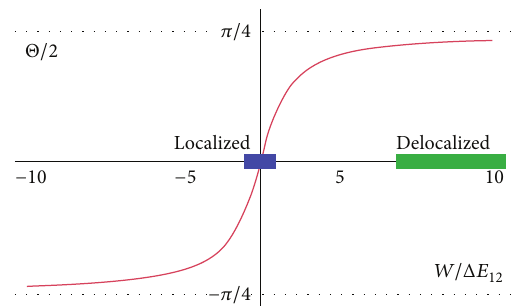
Figure 2: Relation between the parameter Θ and the QW coupling coefficient in a DQW. The ranges for localized and delocalized states of the electron in DQW are shown.